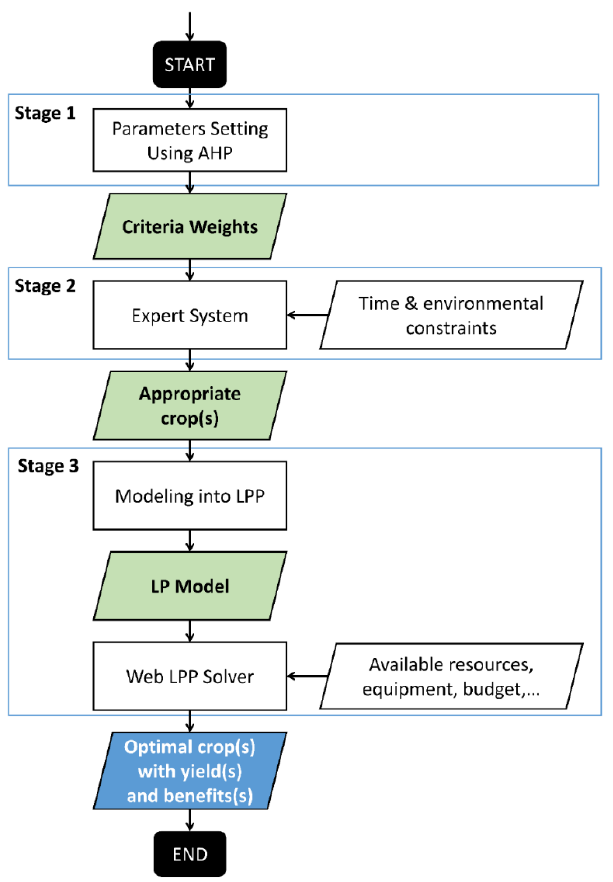
Figure 1 . Flowchart of decision-making process for crop(s) selection Figure 2 . Analytic Hierarchy Process for determining parameters’ weights for cr op